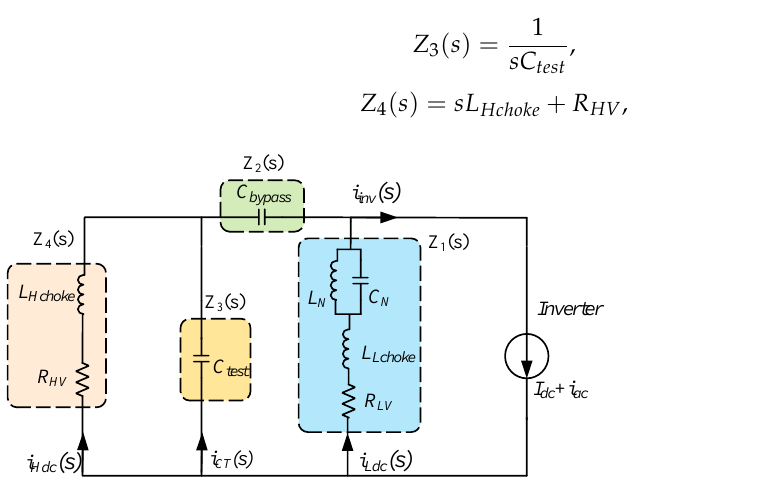
Figure 4. Equivalent circuit focusing on the current flowing into the inverter i inv , capacitor current i CT , high voltage DC current i Hdc , and low voltage DC current i Ldc .